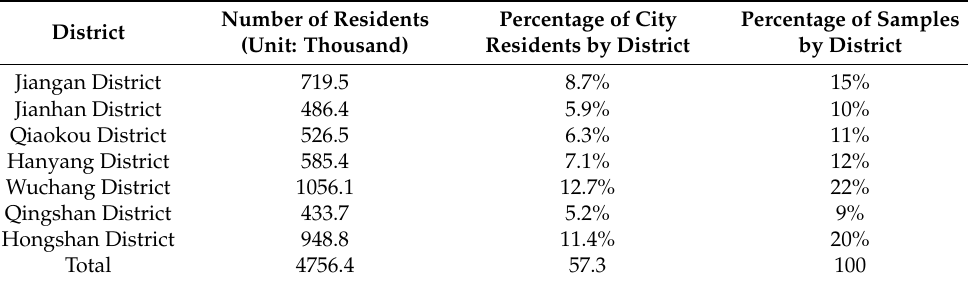
Table 2. Demographic data of central districts in year-end of